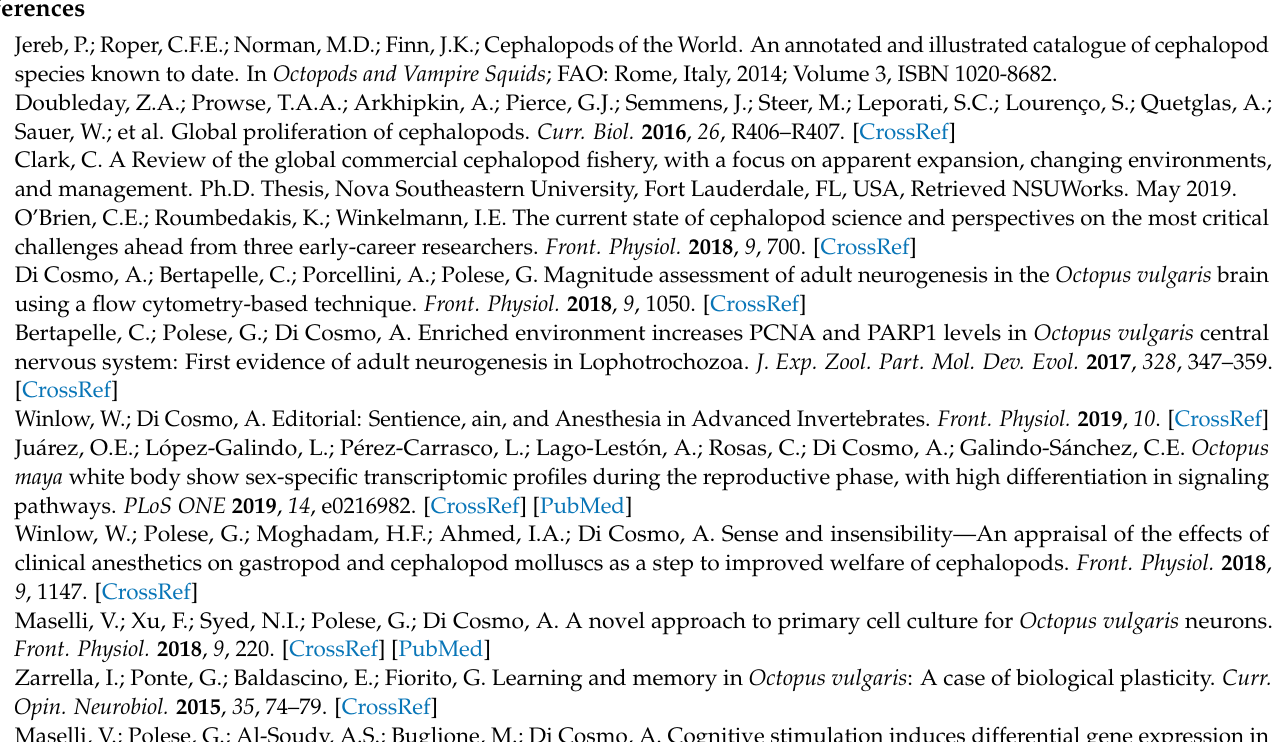
Table S6: Information about countries production ordered by the total number of publications